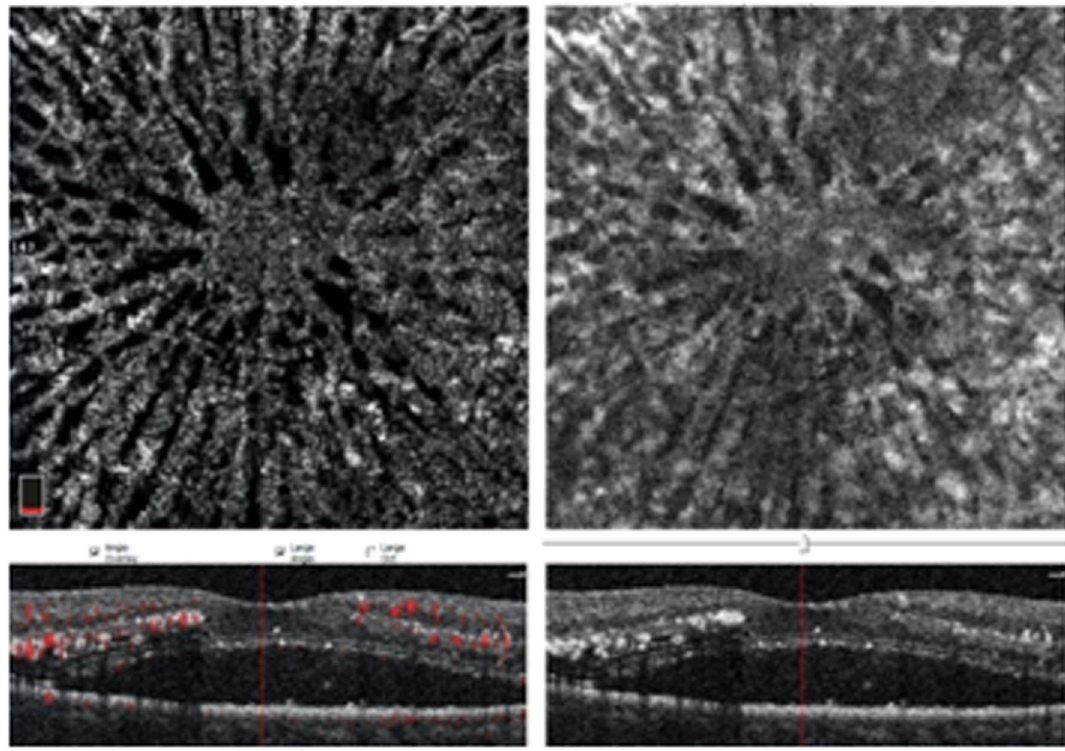
Figure 5. (Patient 24) A 3 mm × 3 mm scan showing CC layer (left image) with Enface projection (right image) of active retinitis. A well demarcated alternating bands of dark and lighter radial striations corresponding to areas of retinal edema in Henle’s layer. CC